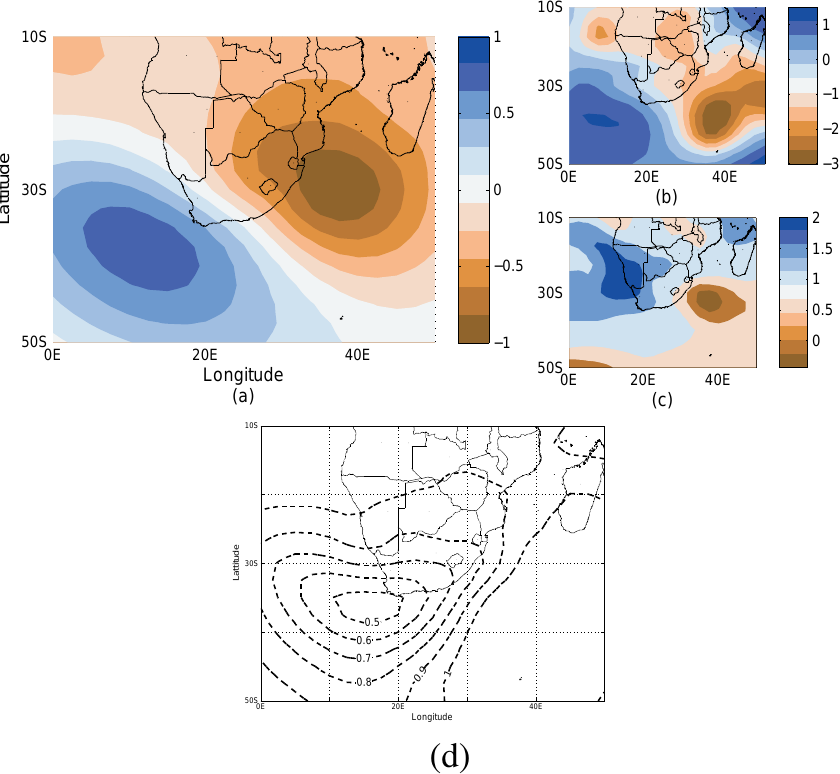
Figure 4. Average anomaly pattern for CP03 (a) with (b) the anomaly with highest DOF, (c) the anomaly with lowest DOF value, while (d) shows the standard deviation for all CP03 anomalies. Fig. 4. Average anomaly pattern for CP03 (a) with (b) the anomaly with highest DOF, (c) the anomaly with lowest DOF value, while (low pressures) can be attributed to the movement of the low- deviation of (1) in the low-pressure region. This can be at- (d) shows the standard deviation for all CP03 anomalies. pressure systems. It is also expected that high-pressure sys- tributed to the movement of low-pressure systems around the tems are more stable with lower variability in their positions. negative anomaly. Figure 4d shows high standard deviation For example Fig. 4d shows lower variability in the vicinity values in comparison to the mean negative anomaly. of the high-pressure region while high variability (standard